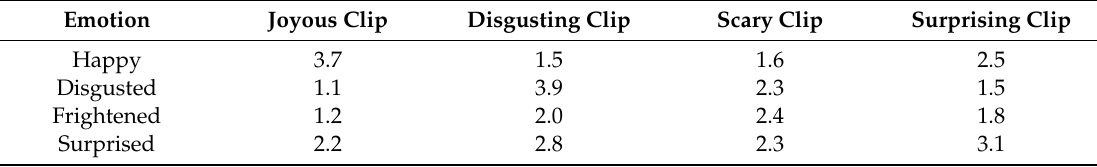
Figure 2. Three-point moving averages of facilitation indices for the Disgust word set whilst viewing the Disgust movie clip. Positive scores indicate disgust, negative scores indicate its opposite (attraction). The peak indices are also shown and a brief description of the content at that point in time. Analysis indicated that the facilitation indices at the seconds 28, 42 − 44, 54 − 58 are significantly different from zero (in each case p < 0.05).